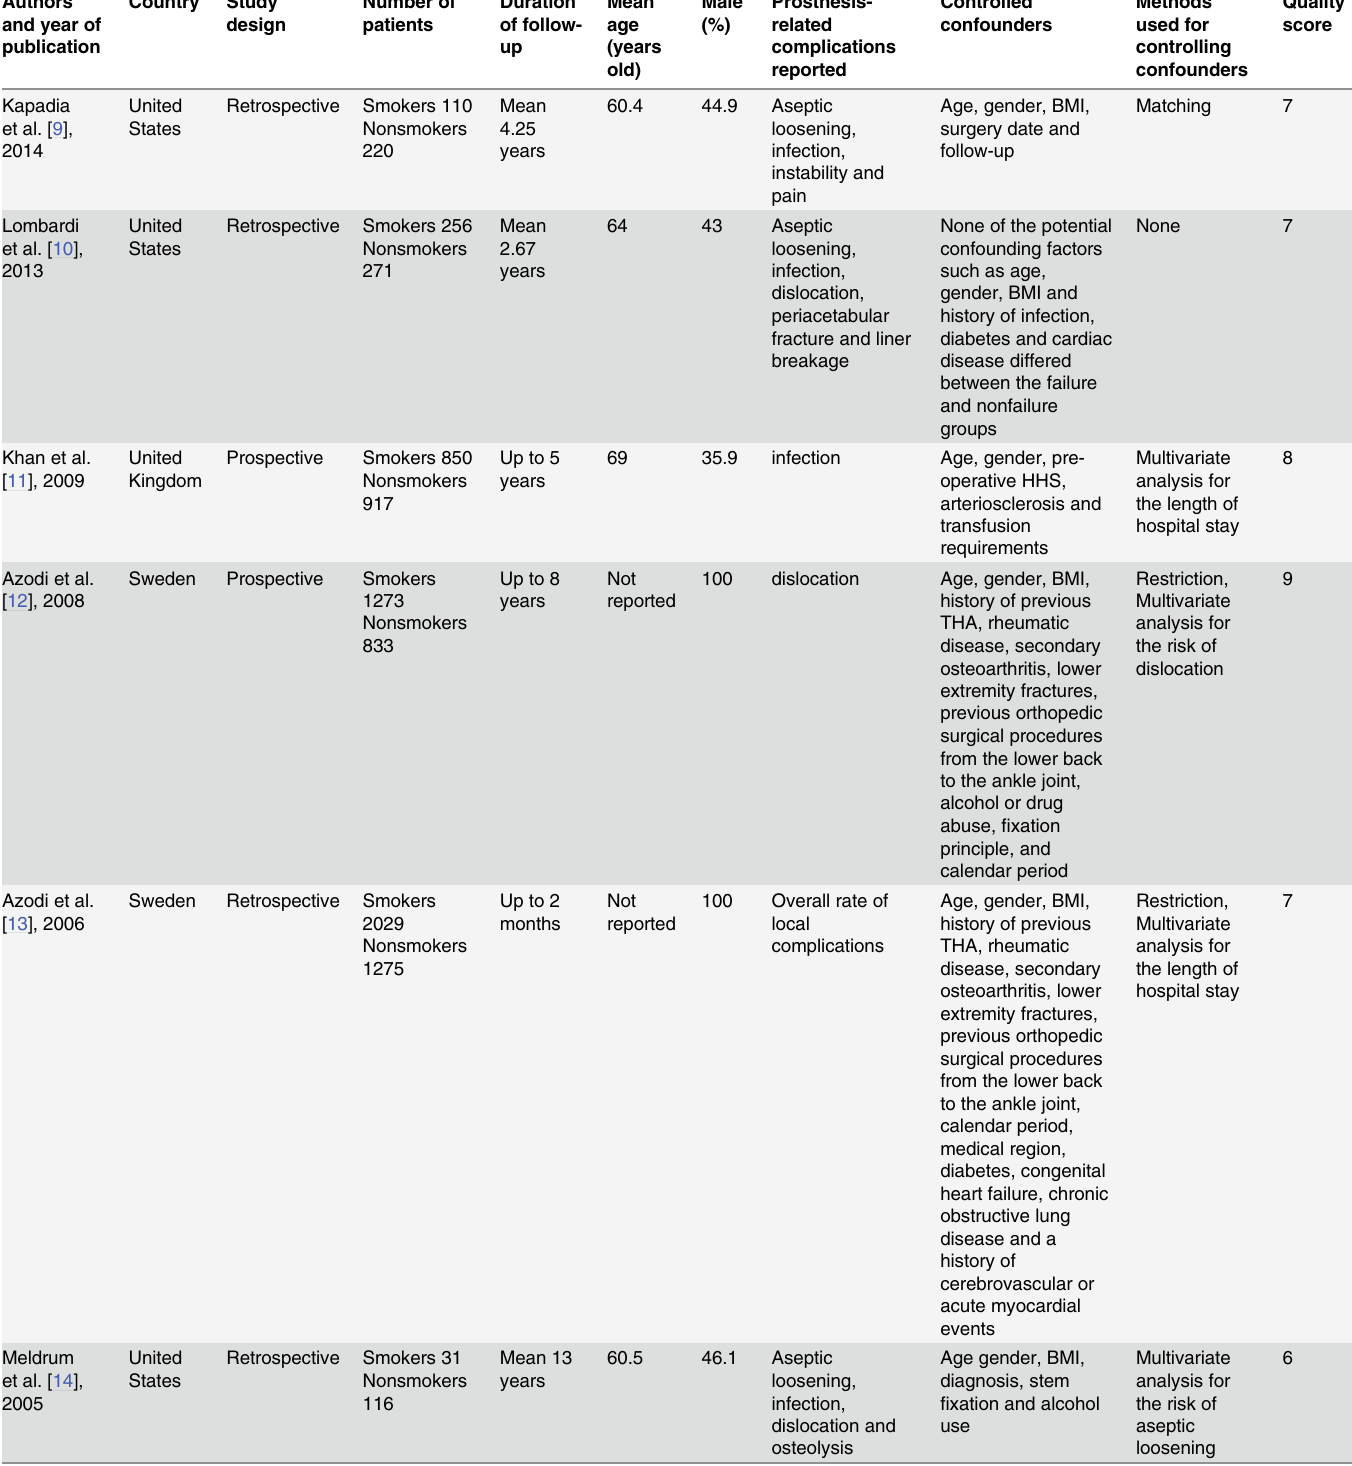
Table 2. Characteristics of the studies included in the